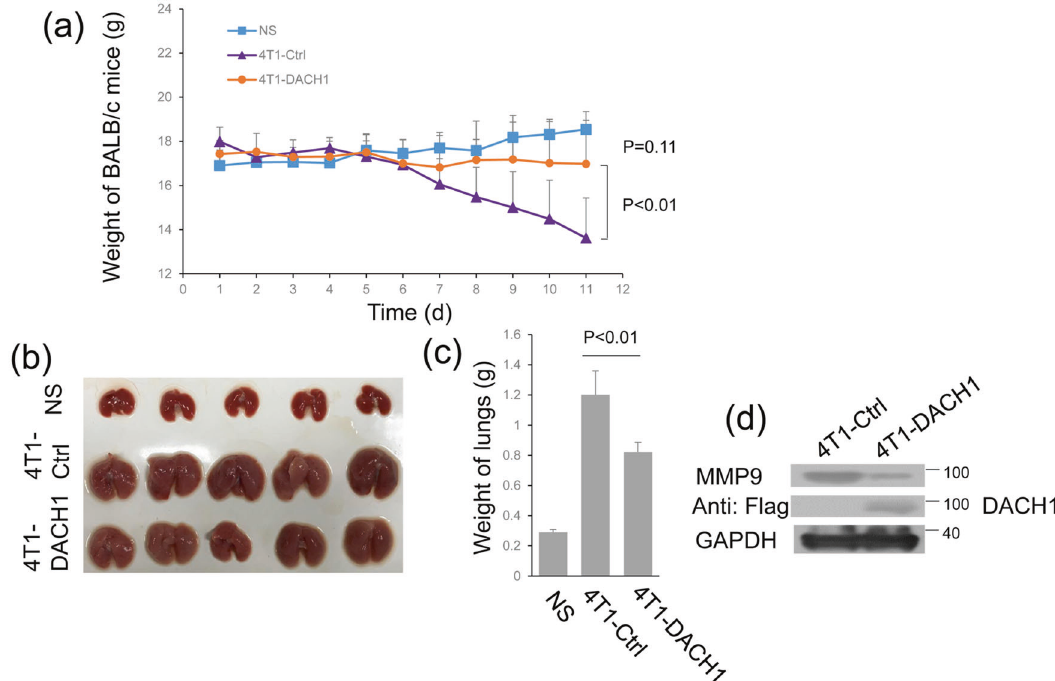
Fig. 6 DACH1 modulates the metastasis of 4T1 cells in BALB/c mice. a Line graph image showing the effect of DACH1 overexpression on the weight of BALB/c mice. b The images showing the effect of DACH1 overexpression on lung size in mice. c The bar graph shows the quantitative measure of the weight of lung in mice. d Western blots showing the MMP9 expression when overexpressed DACH1 into 4T1 cells. The data are representative of three independent experiments. Data are presented as means ± SD ( P < 0.05, signi fi